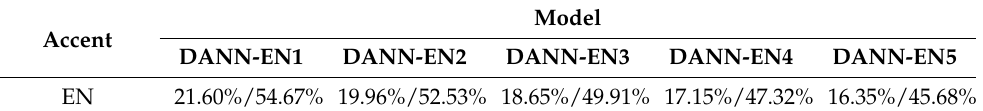
Table 7. Performance (CER/WER) of DANN models according to the amount of EN accent data.